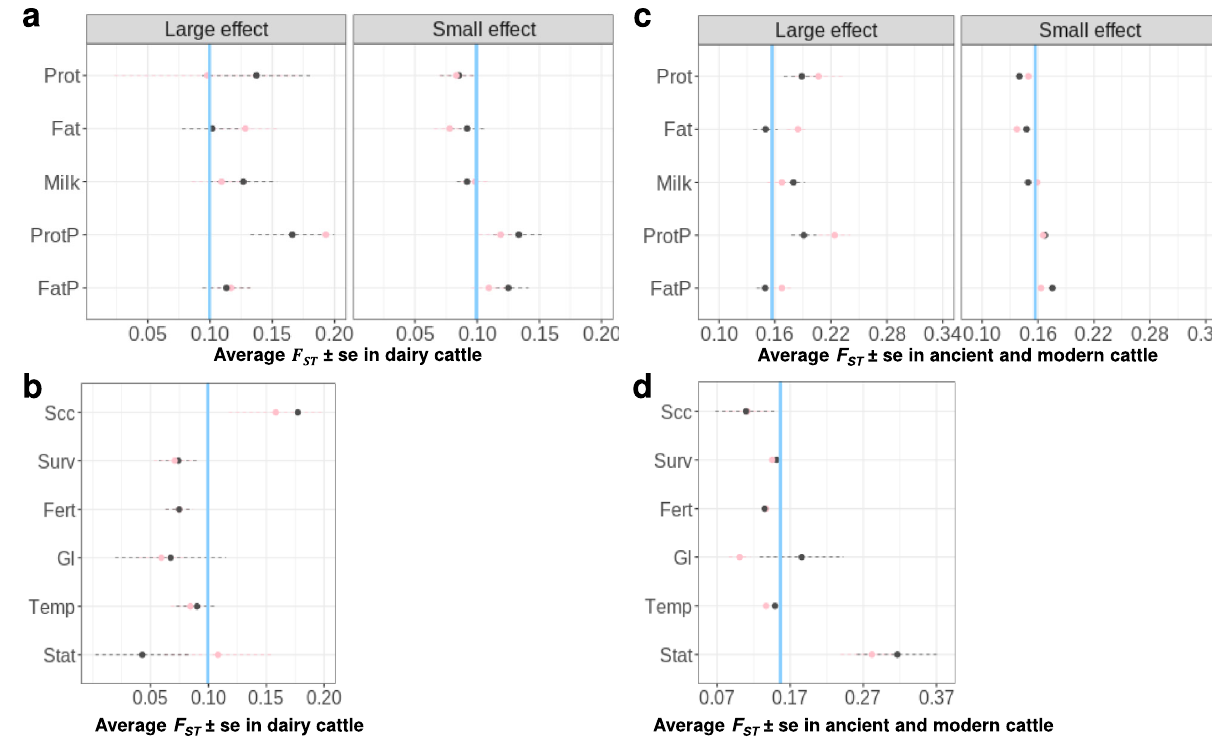
Fig. 4 Selection (average Wright ’ s fi xation index F ST ) of variants with mutant allele that increases or decreases the trait in dairy cattle and ancient and modern cattle. The F ST is shown as dots with its standard error bars estimated using LD-clumped variants. The blue line represents the F ST for 7.9 M variants analysed (0.1 ± 4.3e − 05) in dairy cattle in a , b ; and F ST = 0.157 ± 5e − 05 in ancient and modern cattle in c , d ). In the dairy cattle section ( a , b ), 90,627 Holstein, 13,465 Jersey, 3358 Australian Red (AusRed) and 4649 crossbreds were used. In the ancient and modern cattle ( c , d ), 210 Brahman, 25 Tibetan, 10 Eurasian Aurochs, 242 Simmental, 95 Jersey, 840 Holstein and 287 Angus were used. For b , d , results for survival (Surv), fertility (Fert) and temperament (Temp) were from small-effect MAs, while results for somatic cell count (Scc), gestation length (Gl) and stature (Stat) were from medium- effect